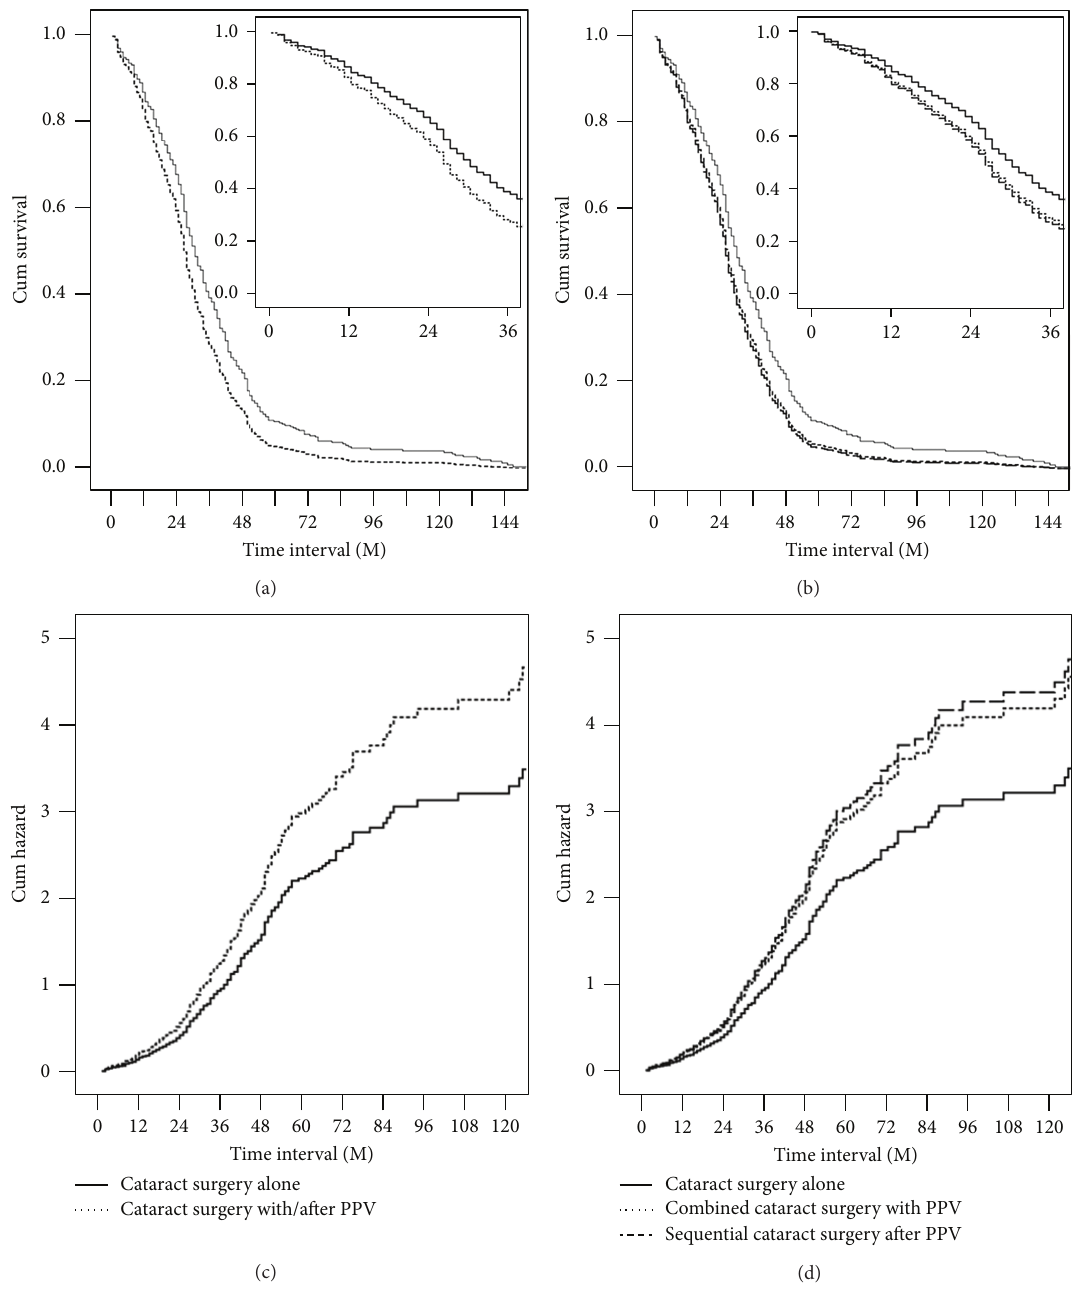
Figure 4: Cox proportional hazards model. Surgical option was identified as a risk factor that influenced the time interval from cataract surgery to capsulotomy. The CV group had a higher risk of a shorter Nd:YAG capsulotomy free survival time than the CA group ((c), hazard ratio (HR) = 1.337; 95% confidence interval (CI) 1.100–1.625; 𝑃 = 0.003 ). Combined surgery and sequential surgery were associated with an increased risk of a shorter Nd:YAG capsulotomy free survival time ((d), HR = 1.304; 95% CI; 1.007–1.688; 𝑃 = 0.44 , HR = 1.361; 95% CI = 1.084–1.709; 𝑃 = 0.008 , resp.). The CA group showed a longer Nd:YAG capsulotomy free survival than the CV group (a) and both the C-CV and S-CV groups